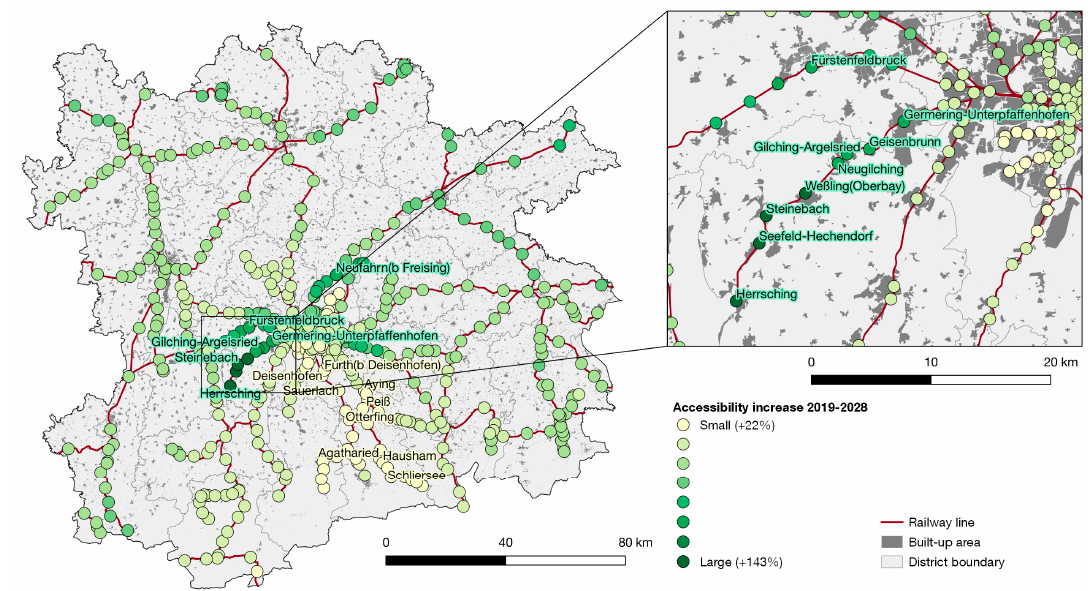
Figure 5. Change of accessibility of population with rail-based public transport at railway stations in the MMR 2019–2028 (Source: own work, using geodata by Bayerische Vermessungsverwaltung, Bundesamt für Kartographie und Geodäsie, Deutsche Bahn).